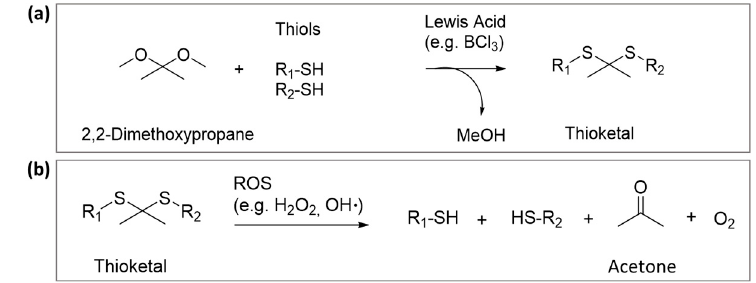
Figure 1. ( a ) Mechanism of synthesis of TK by condensation of thiols with ketones (readapted from numerous similar reactions from articles by El-Mohtadi et al. [26], McEnery et al. [30] and Ling et al. [31] and ( b ) chemical degradation of TK groups by ROS [25].